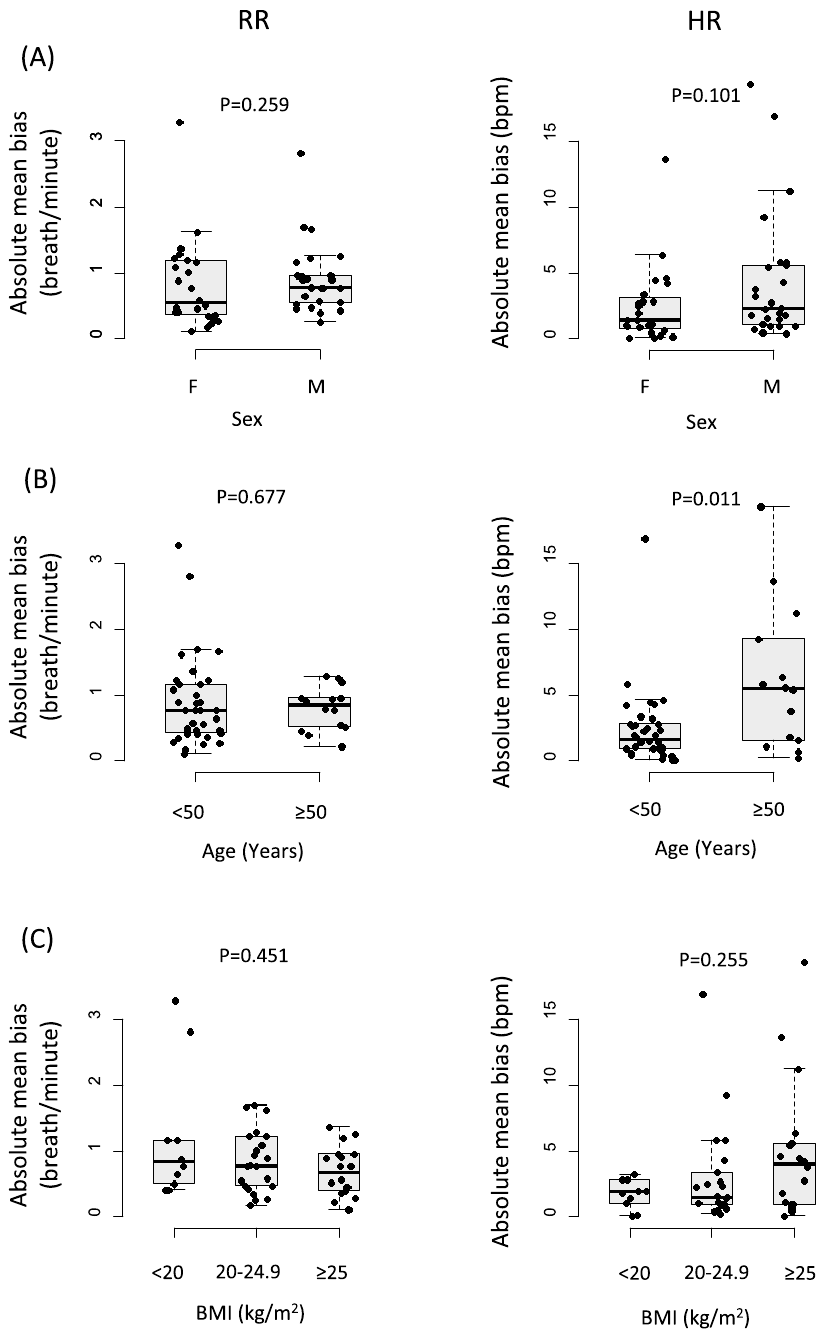
Figure 5. Comparisons of mean absolute biases between the radar and the conventional monitor according to sex, age and BMI. ( A – C ) represent the absolute bias levels in RRs and HRs according to sex, age and BMI, respectively. Absolute biases of RRs were lower in the BMI ≥ 25 kg/m 2 , whereas absolute biases of HRs are greater in male, in patients ≥ 50 years and in those with BMI ≥ 25 kg/m y in both the supine and the sitting